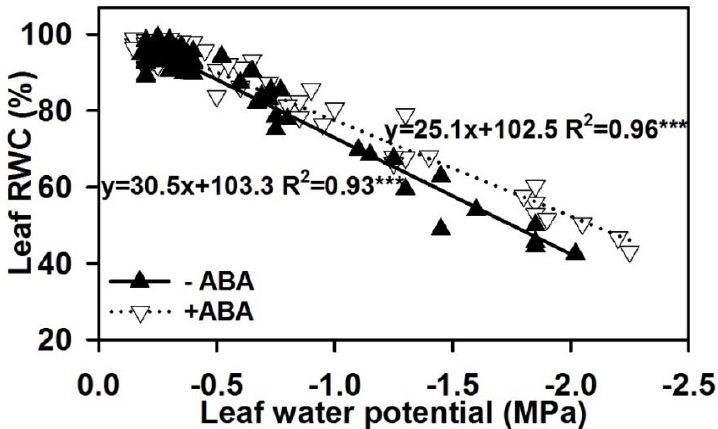
Figure 5. The effects of 10 µM exogenous ABA on leaf relative water content (RWC) changed with leaf water potential decreasing in the soybean cultivar Jindou 19 (JD). One day before withholding water, plants were pretreated with (+ABA) or without (−ABA) 10 µM exogenous ABA.